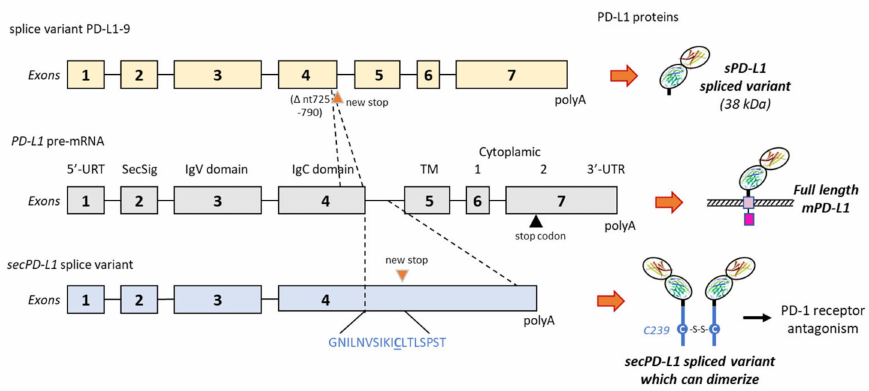
Figure 5. Two examples of alternative splicing of the PD-L1 pre-mRNA. The exons’ and introns’ organization of full-length PD-L1 is shown in the middle, and the full-length PD-L1 protein is shown on the right with its different domains (as in Figure 1). Above, the splice variant PD-L1-9, which has lost a 66-bp region from nt-725 to 790 in exon 4. The deletion indicates a frame shift leading to a stop codon before the transmembrane domain (TM). The variant produces a truncated sPD-L1 protein (38 kDa) lacking the TM and intracellular domains [48]. Below is an alternatively spliced form of the human PD-L1 cDNA from placental tissue. The variant contains the first 4 exons of PD-L1, including the secretory signal (SecSig) at the N-terminus, IgV and IgC domains, which are shared with the full-length PD-L1. The variant does not splice into the fifth exon (encoding the transmembrane domain) but reads into the fourth intron, within a new stop codon. It produces an mRNA that lacks a transmembrane domain at its 3 (cid:48) end and leads to a protein with the indicated unique C- terminal sequence. The underlined cysteine residue (C239) allows for protein homodimerization, as represented on the right side. The expressed protein, naturally dimerizing, was found to inhibit T-cell proliferation and production of IFN- γ from activated T-cells